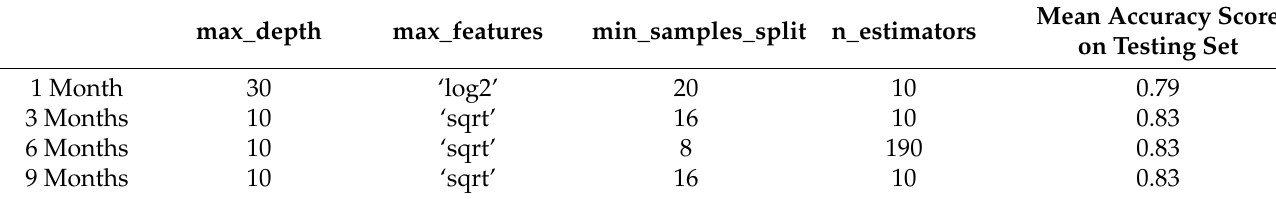
Table 4. Optimal hyperparameters and mean accuracy score of models developed by different training set size.